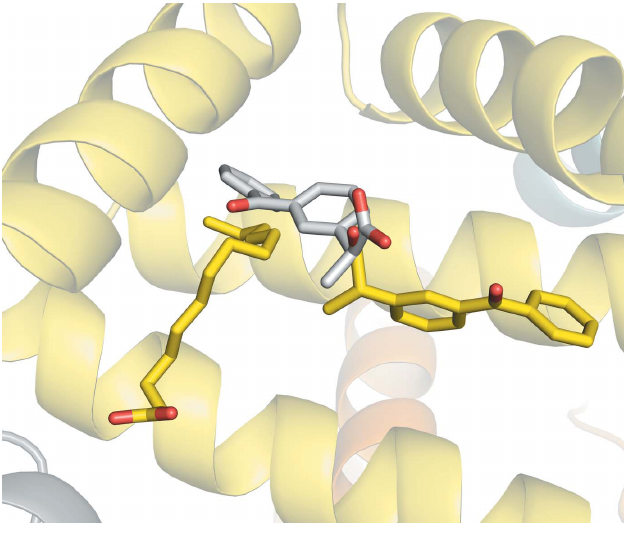
Figure 6 Comparison of ( S )-ketoprofen binding to drug site 2 in HSA (PDB entry 7jwn) and LSA (PDB entry 6ock). The ( S )-ketoprofen molecule and a molecule of a fatty acid bound to HSA are shown in stick representation with O atoms in red and C atoms in yellow, while a molecule of ( S )-ketoprofen bound to LSA is shown in stick representation with O atoms in red and C atoms in gray. The colors of the helices correspond to the colors used in Fig.